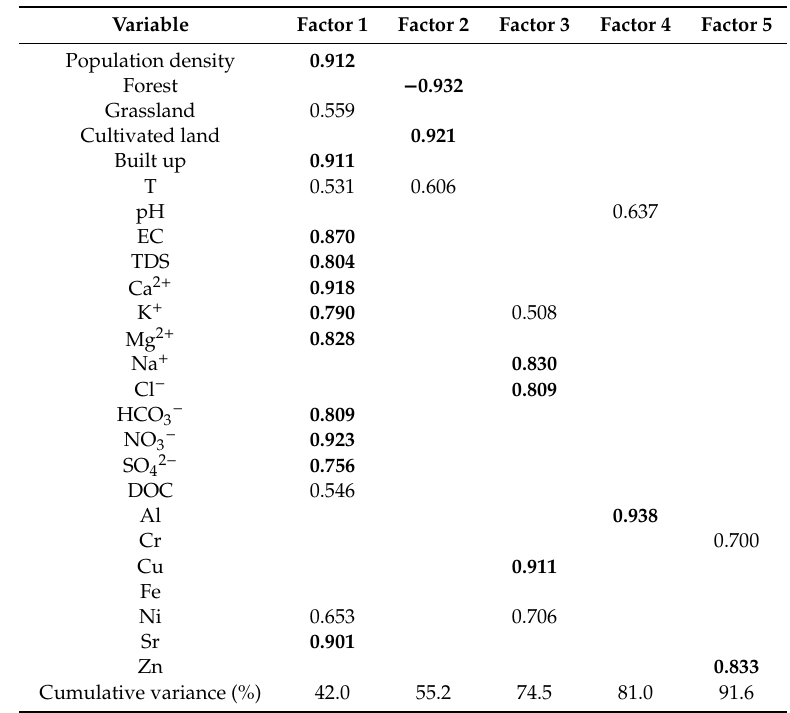
Table 4. Varimax rotated factor loading matrix from PCA for winter in the Nongkrem catchment (sub-catchments: F1, F2, C1, C2, M1, M2, M3, M4, M5). Strong correlations ( ≥ 0.75) are indicated by bold type, and moderate loadings ( ≥ 0.50 and < 0.75) are shown in normal type.